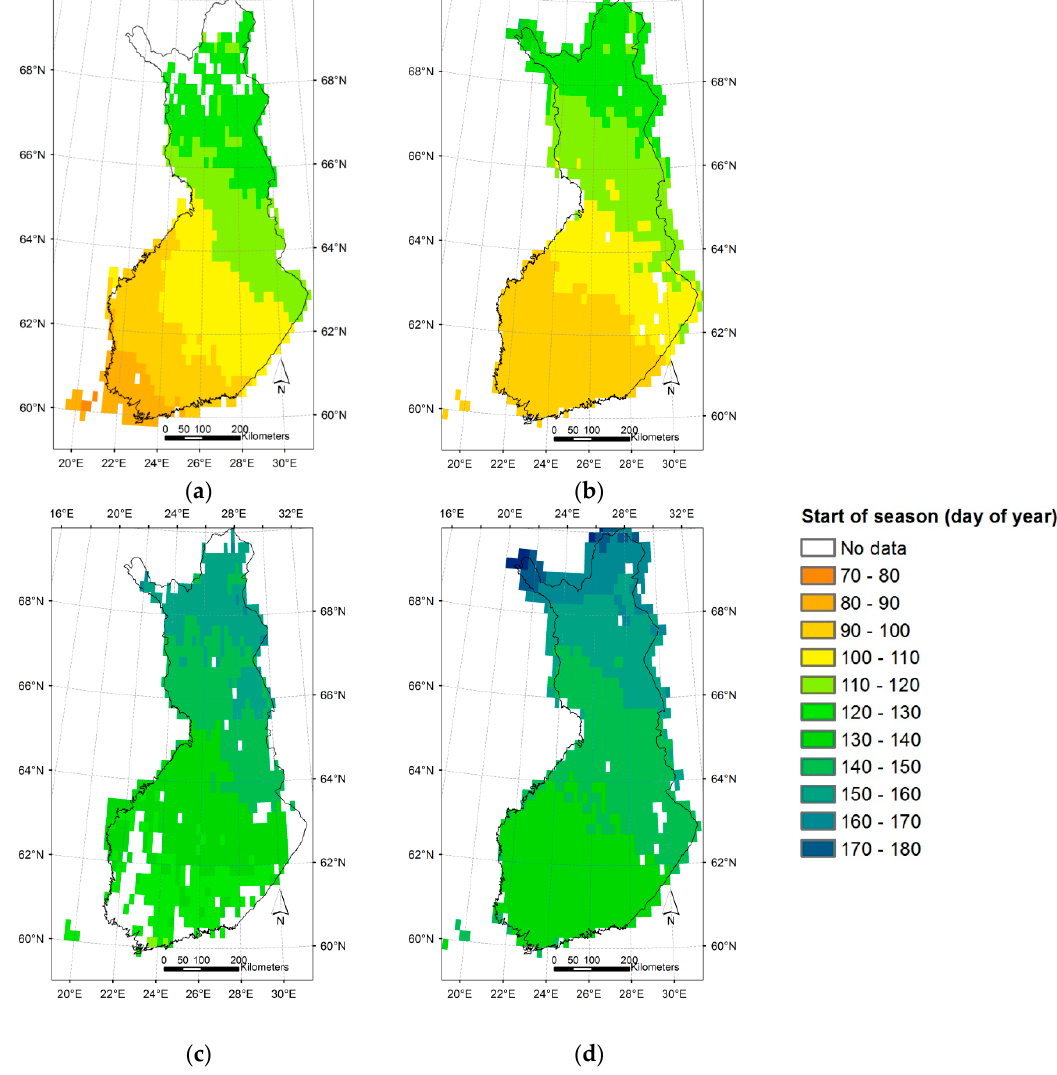
Figure 6. Spatial distribution of mean start of season dates in Finland for the period 2003–2010. The upper panel shows estimates for evergreen needle-leaf forest: ( a ) determined from satellite observation, and ( b ) determined from JSBACH simulations. The lower panel shows estimates for deciduous broad-leaf forest: ( c ) determined from satellite observations and ( d ) from JSBACH simulations.